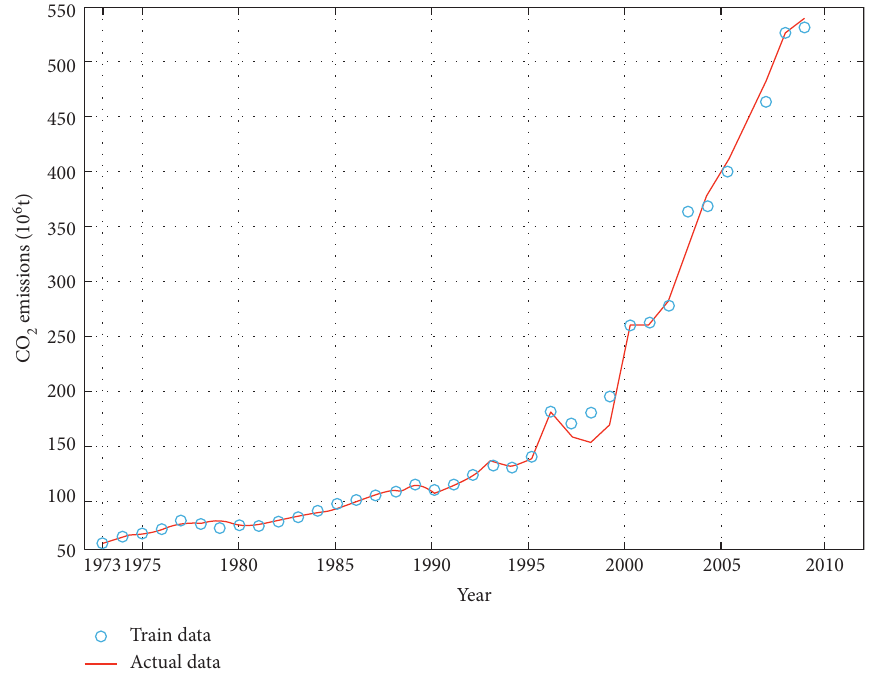
Figure 6: Comparison of the predicted value of the training sample with the actual value.